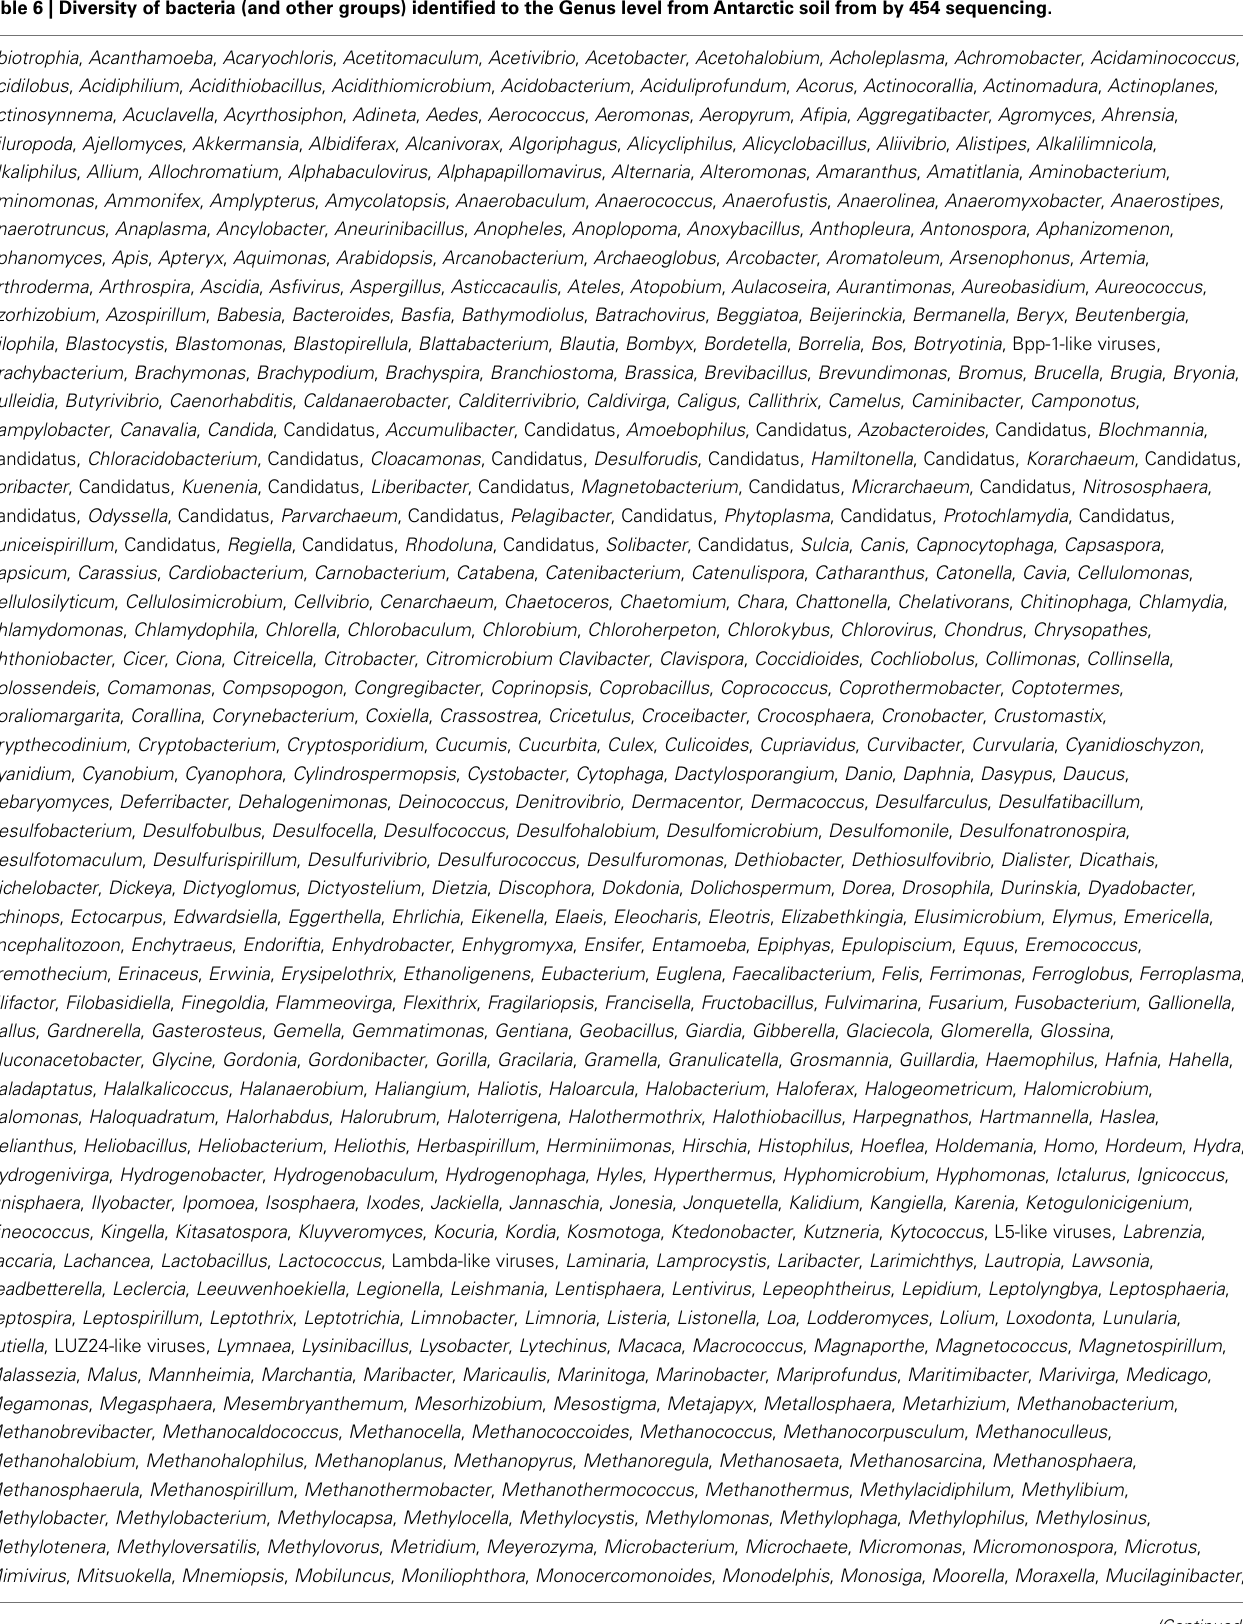
Table 6 | Diversity of bacteria (and other groups) identified to the Genus level fromAntarctic soil from by 454